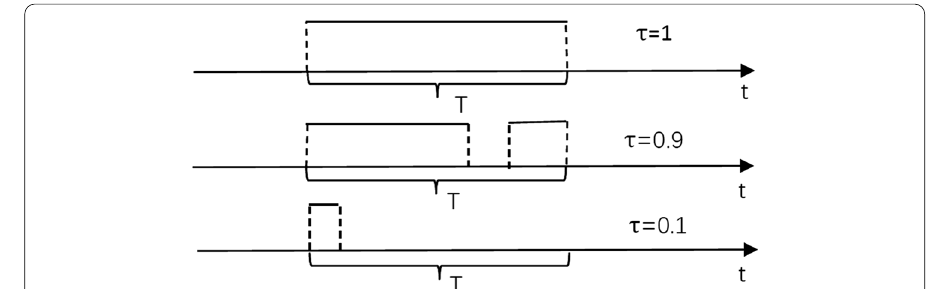
Fig. 8 The test signal of abnormal opening of outer manhole cover